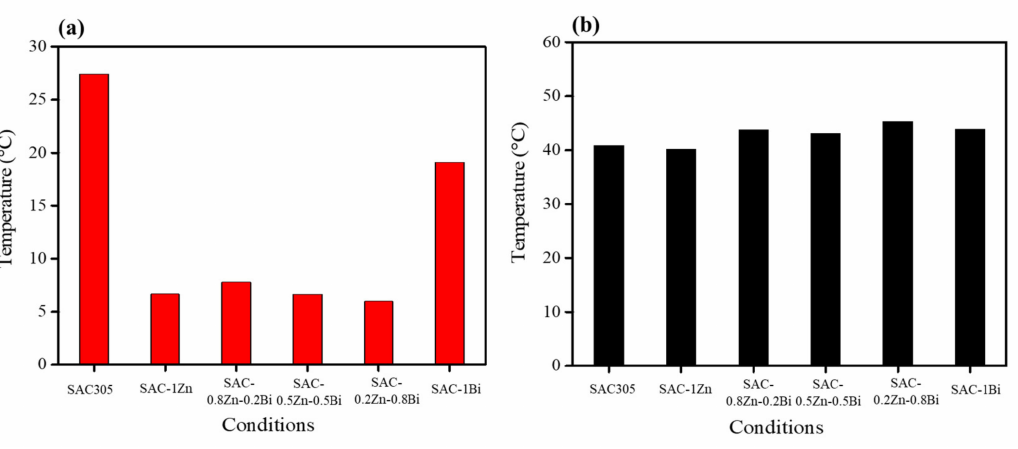
Figure 3. ( a ) Undercooling ( ∆ T 1 = T onset − T cool ) and ( b ) Pasty range ( ∆ T 2 = T end − T onset )